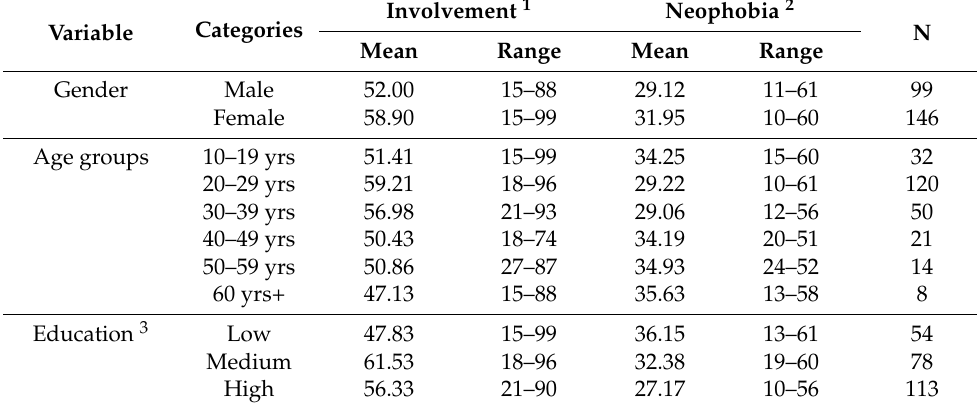
Table 2. Product involvement and food neophobia scores by gender, age, and